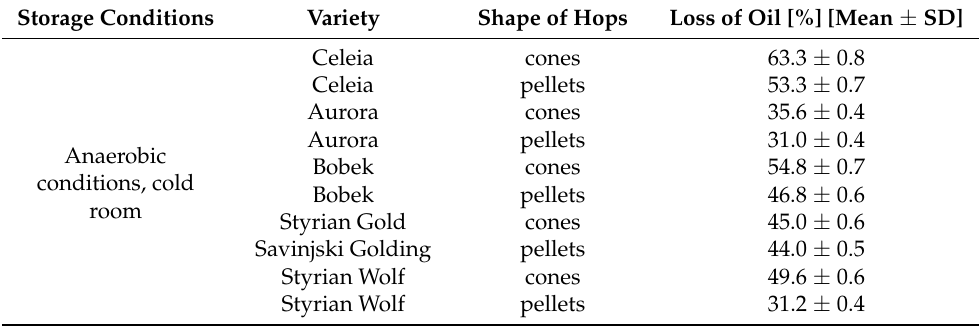
Table 2. Loss of the hop essential oil in% with standard deviations, after two years of storage under different